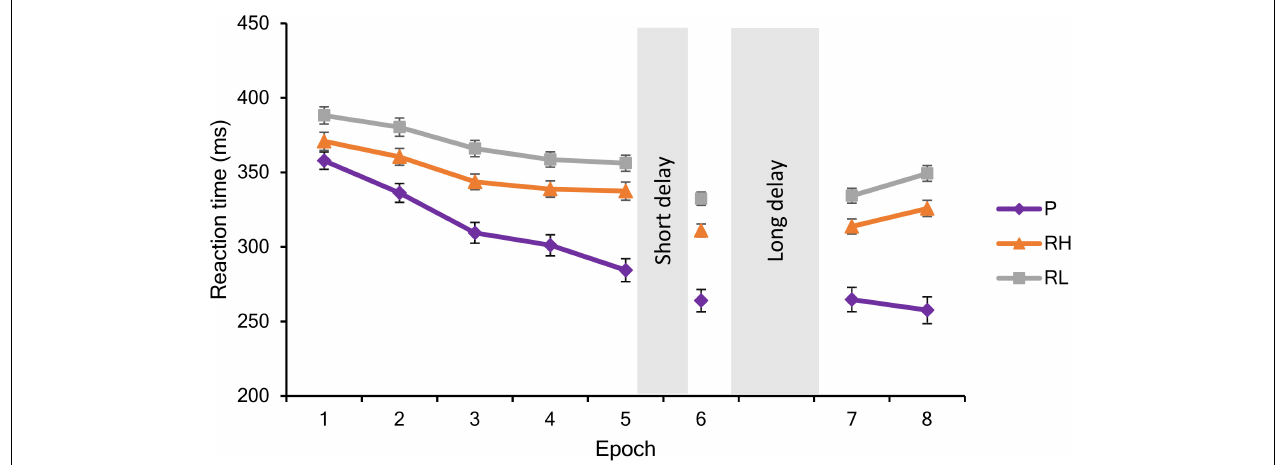
FIGURE 2 | Performance during the training (Epochs 1–5), testing (Epoch 6) and retesting (Epochs 7–8) sessions. Mean reaction times and standard errors are visualized in response to pattern (P), random high (RH), and random low (RH) trials during each epoch.